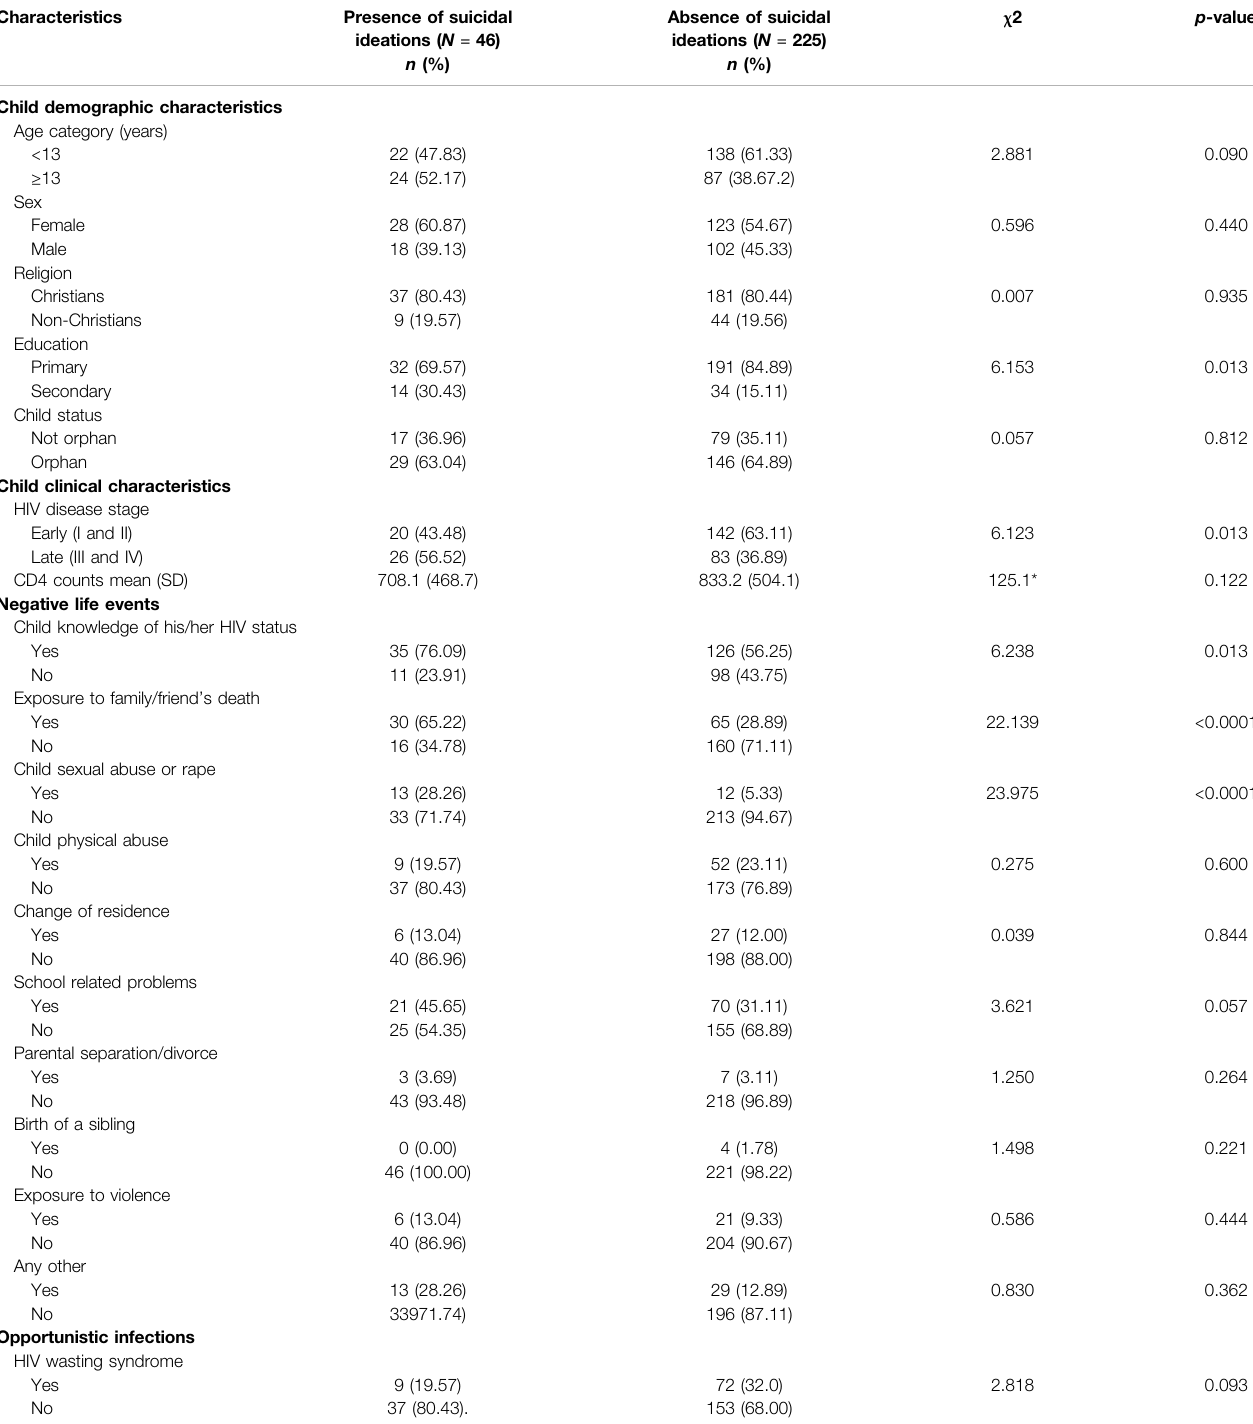
TABLE 2 | The demographic and clinical pro fi les of study participants associated with suicidal ideations at Bivariate analysis ( N (cid:1) 271).